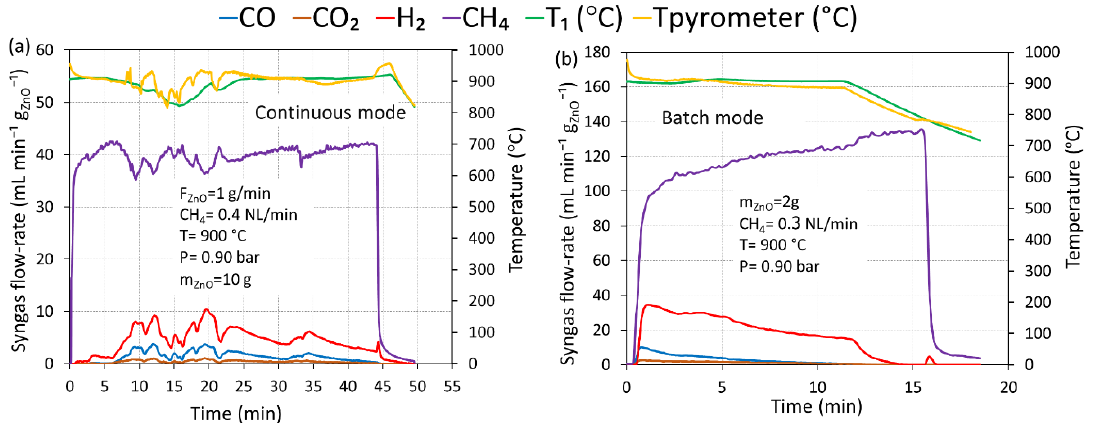
Figure 6. Typical syngas production rates and reactor temperatures evolution for methane-driven ZnO reduction (at 900 °C and 0.90 bar): ( a ) continuous mode and ( b ) batch mode. Source: author.